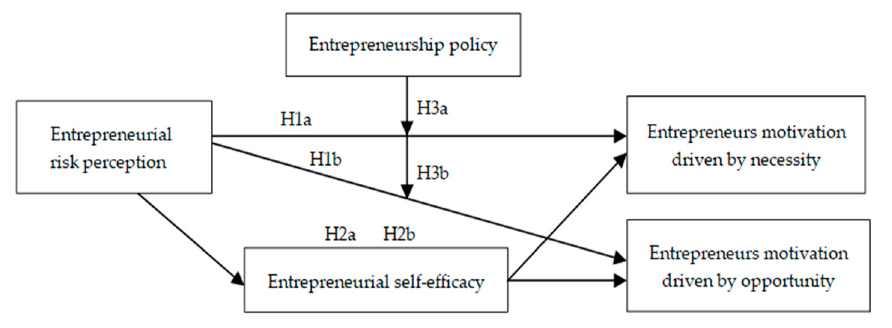
Figure 1. Research